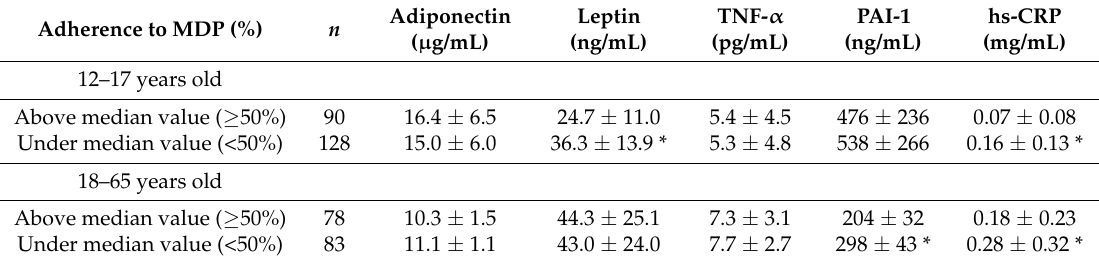
Table 3. Levels of inflammatory markers in adult female subjects according to the adherence to the MDP. Adherence to MDP